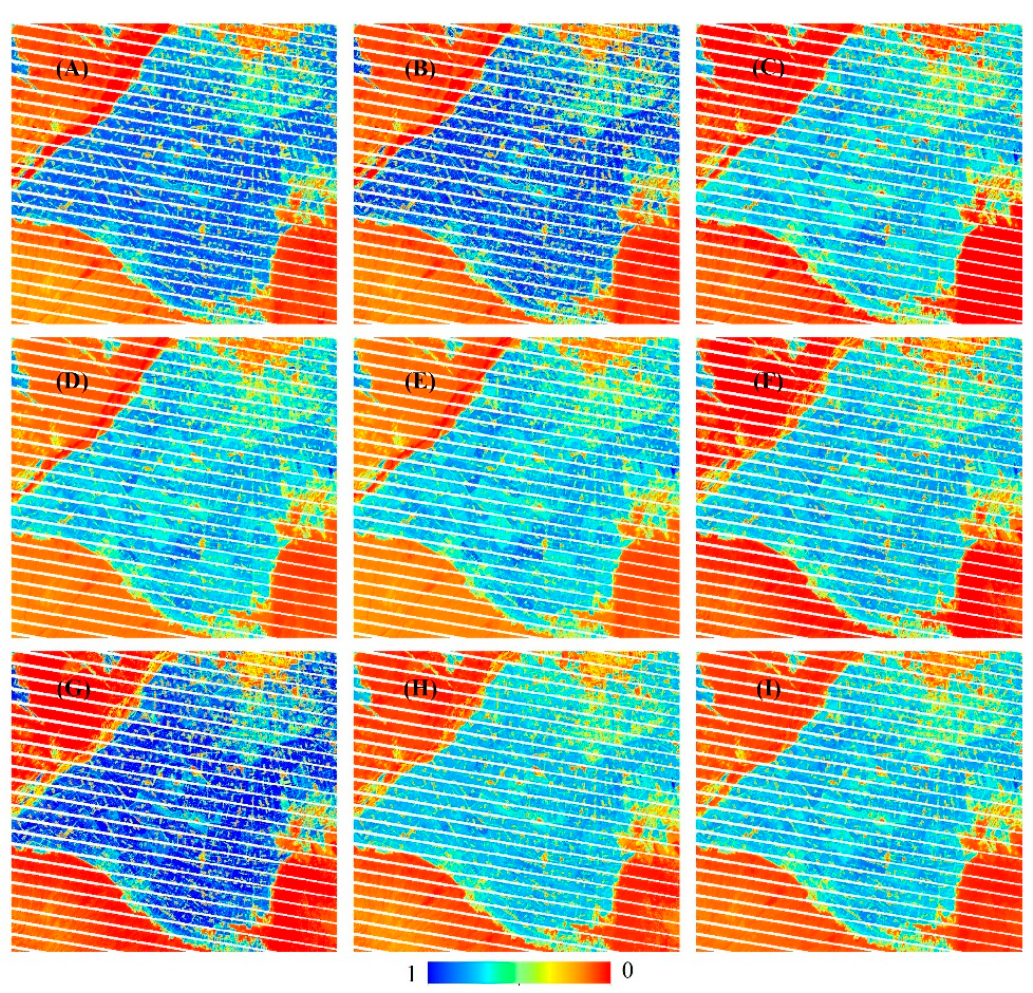
Figure 4. FVC estimates from the individual models and the two (multiple linear regression (MLR) and Bayesian model averaging (BMA)) combination methods. ( A ) Pixel dimidiate model using normalized difference vegetation index (NDVI); ( B ) Pixel dimidiate model using enhanced vegetation index (EVI); ( C ) three gradient differential vegetation index (TGDVI); ( D ) modified three gradient differential vegetation index 1 (MTGDIV1); ( E ) modified three gradient differential vegetation index 2 (MTGDVI2); ( F ) spectral mixture analysis with three endmembers (SMA3) model and ( G ) spectral mixture analysis with four endmembers (SMA4) model; ( H ) MLR method using seven individual models; ( I ) BMA method using seven individual models.